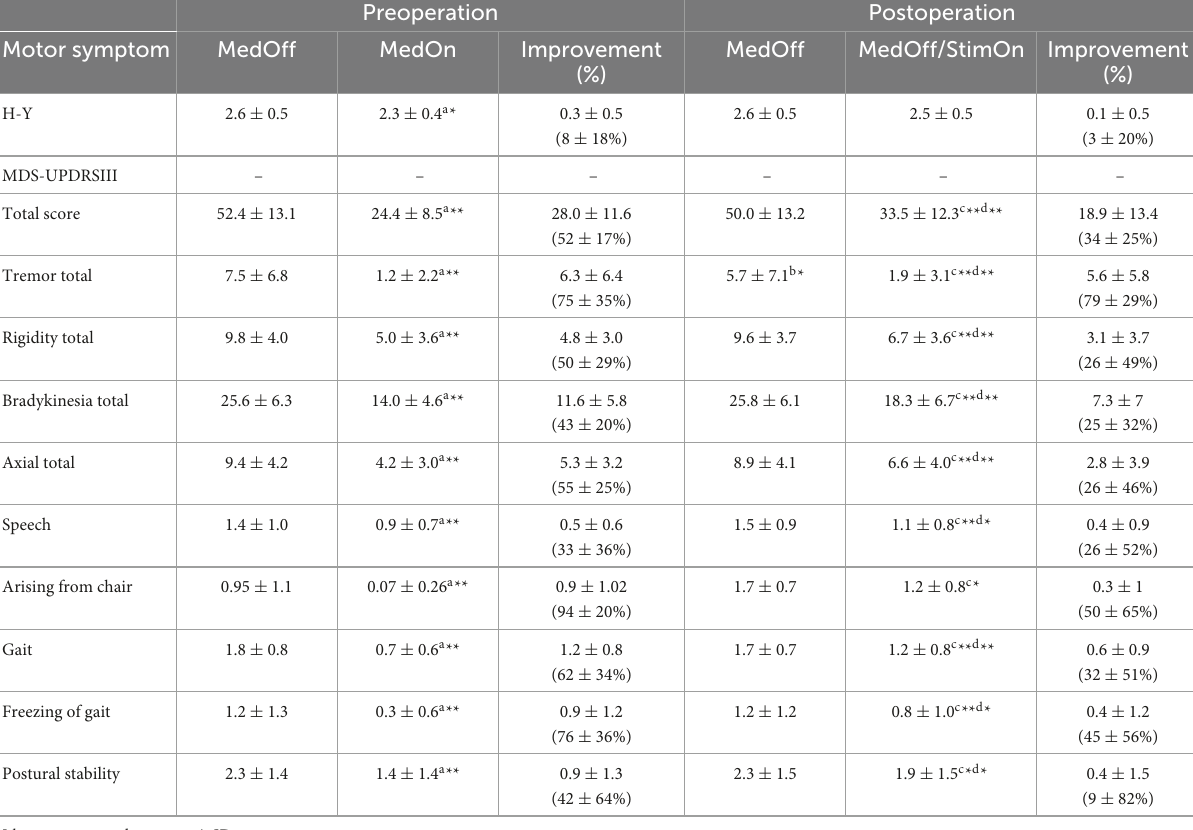
TABLE 2 Deep brain stimulation (DBS) outcomes of the whole